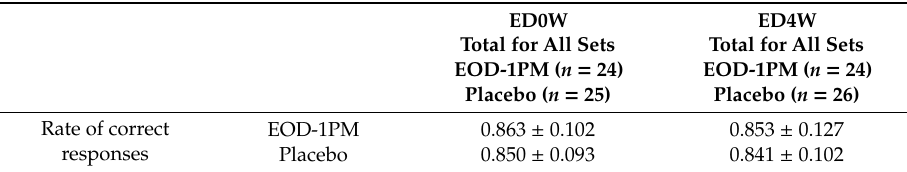
Table 5. The rate of correct responses in the 2-back tasks.